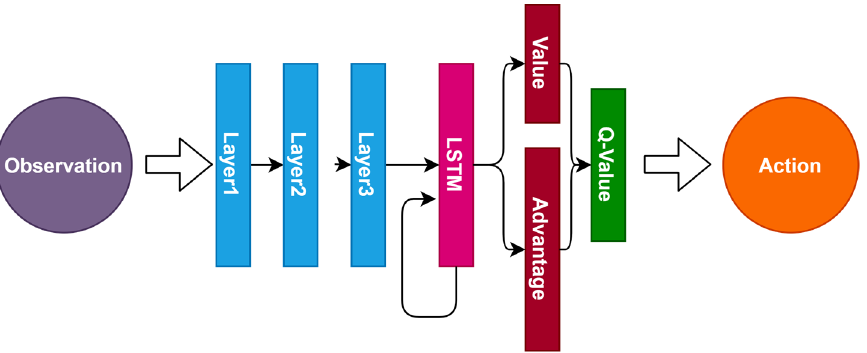
Figure 1. The network structure of the D3RQN.